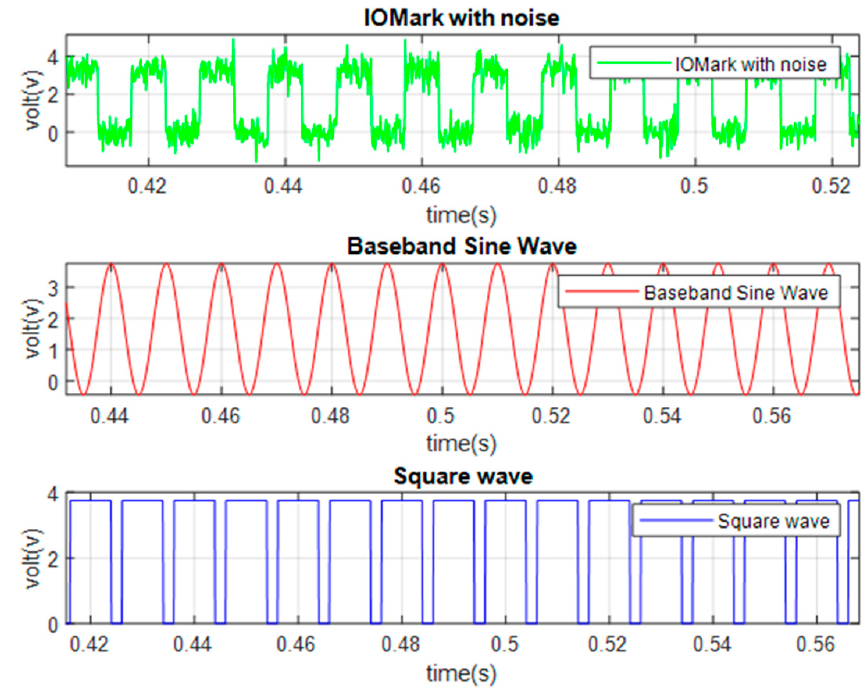
Figure 13. Clock signal normalization process (adapted from [13]).